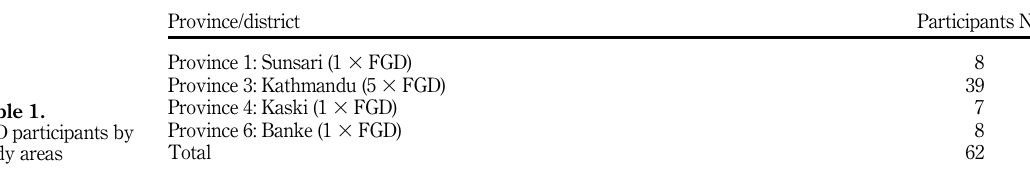
Table 1. FGD participants by study